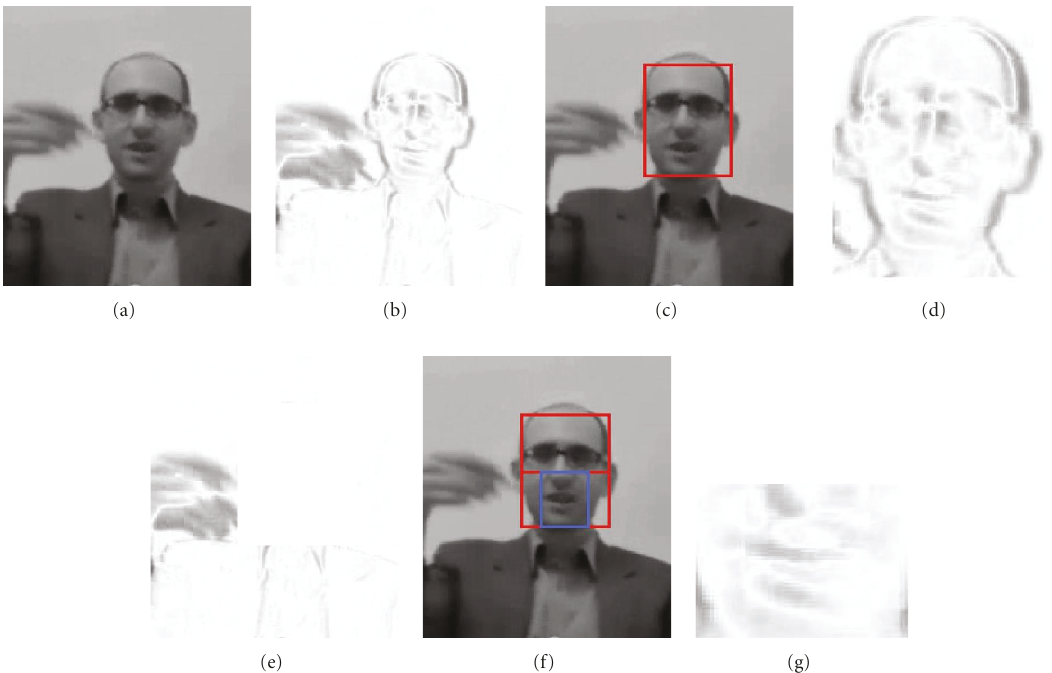
Figure 1: (a) i th frame from dialog, (b) Global movement GM ij , (c) Detected face F i , (d) Face movement FM ij , (e) Body movement BM ij , (f) Mouth detection M i , and (g) Mouth movement MM ij